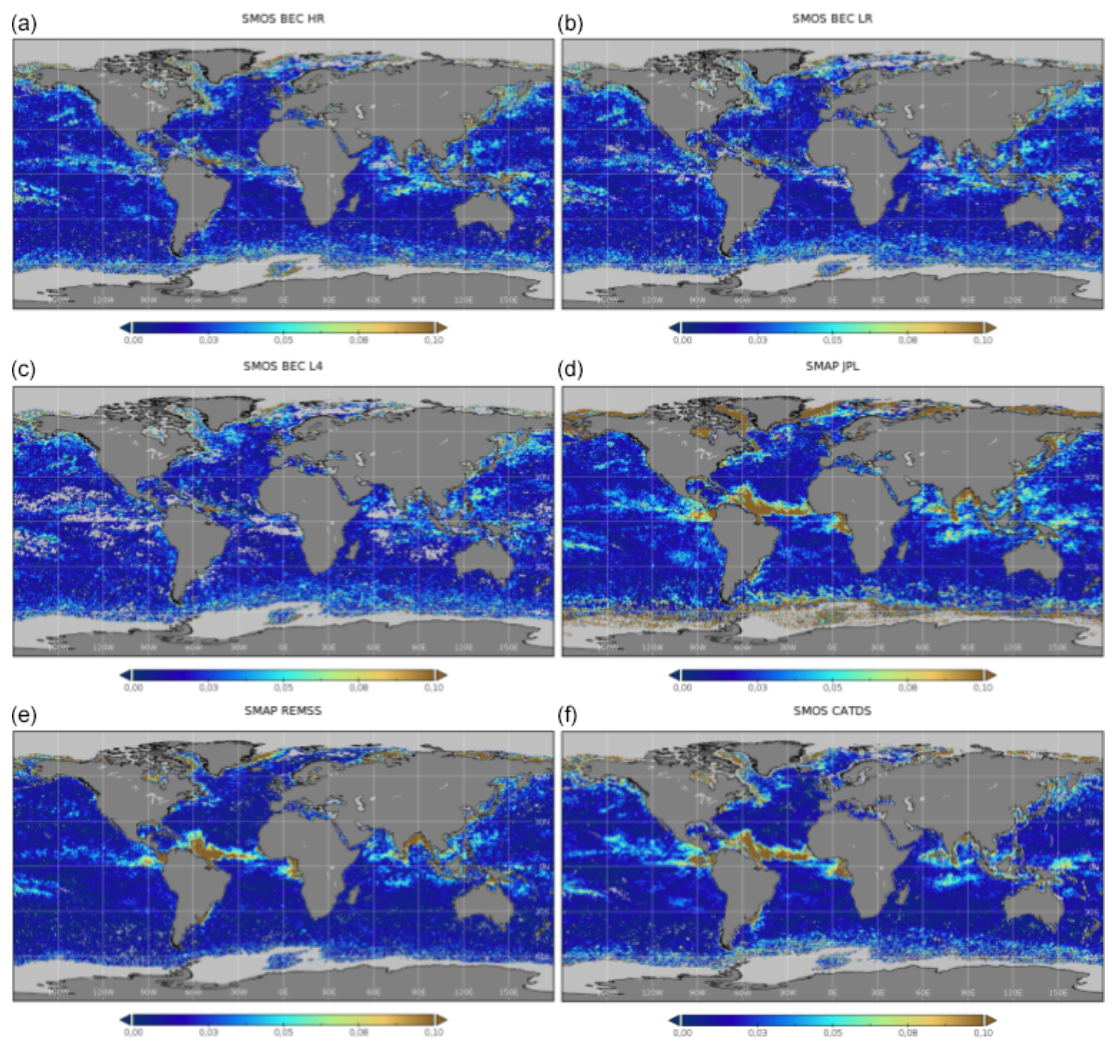
Figure 18. Uncertainty in the SSS error estimation by triple collocation from top to bottom and left to right: BEC HR, BEC LR, BEC L4, JPL, REMSS, and